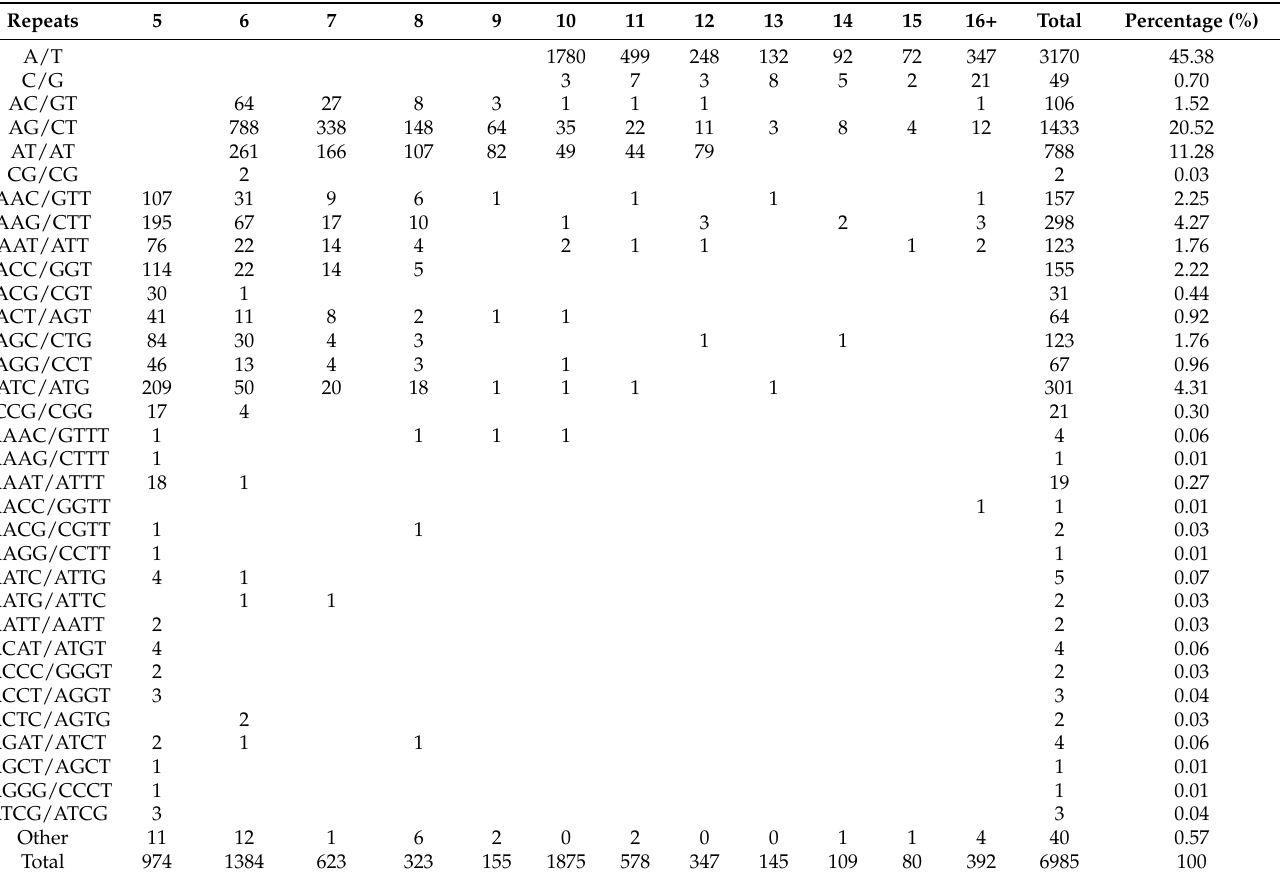
Table 5. Frequencies of different repeat motifs in SSRs of C. macrophyllum